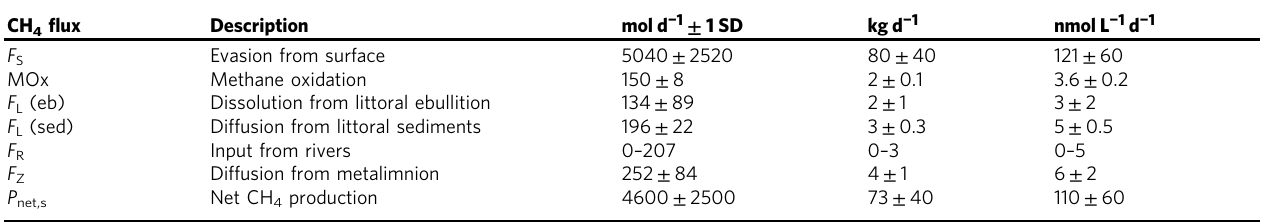
Table 2 Methane mass balance for the surface mixed